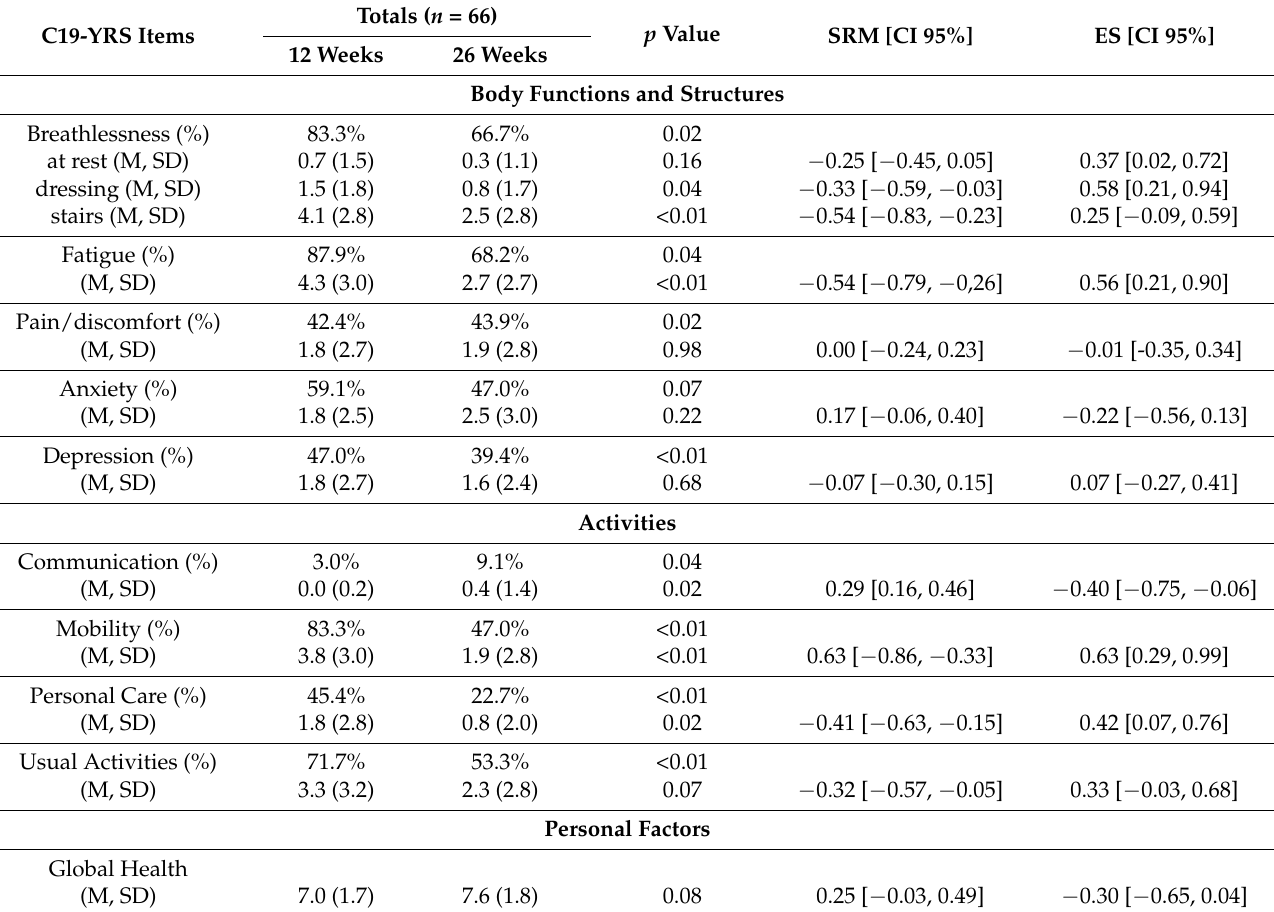
Table 5. Responsiveness of COVID-19 symptoms at 12 and 26 weeks. Abbreviations: ICU =